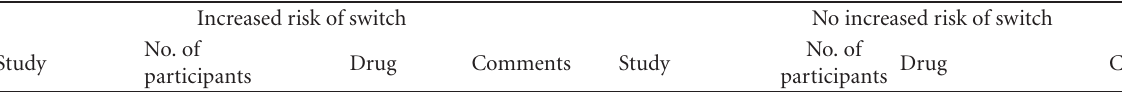
Table 2: Summary of recent studies examining the risk of manic/hypomanic switch following the use of antidepressants in the treatment of acute bipolar